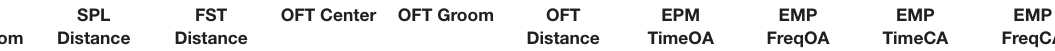
TABLE 1 | Spearman’s correlations amongst behavioral variables assessing depression-like and anxiety-like behaviors. Spearman’s correlations